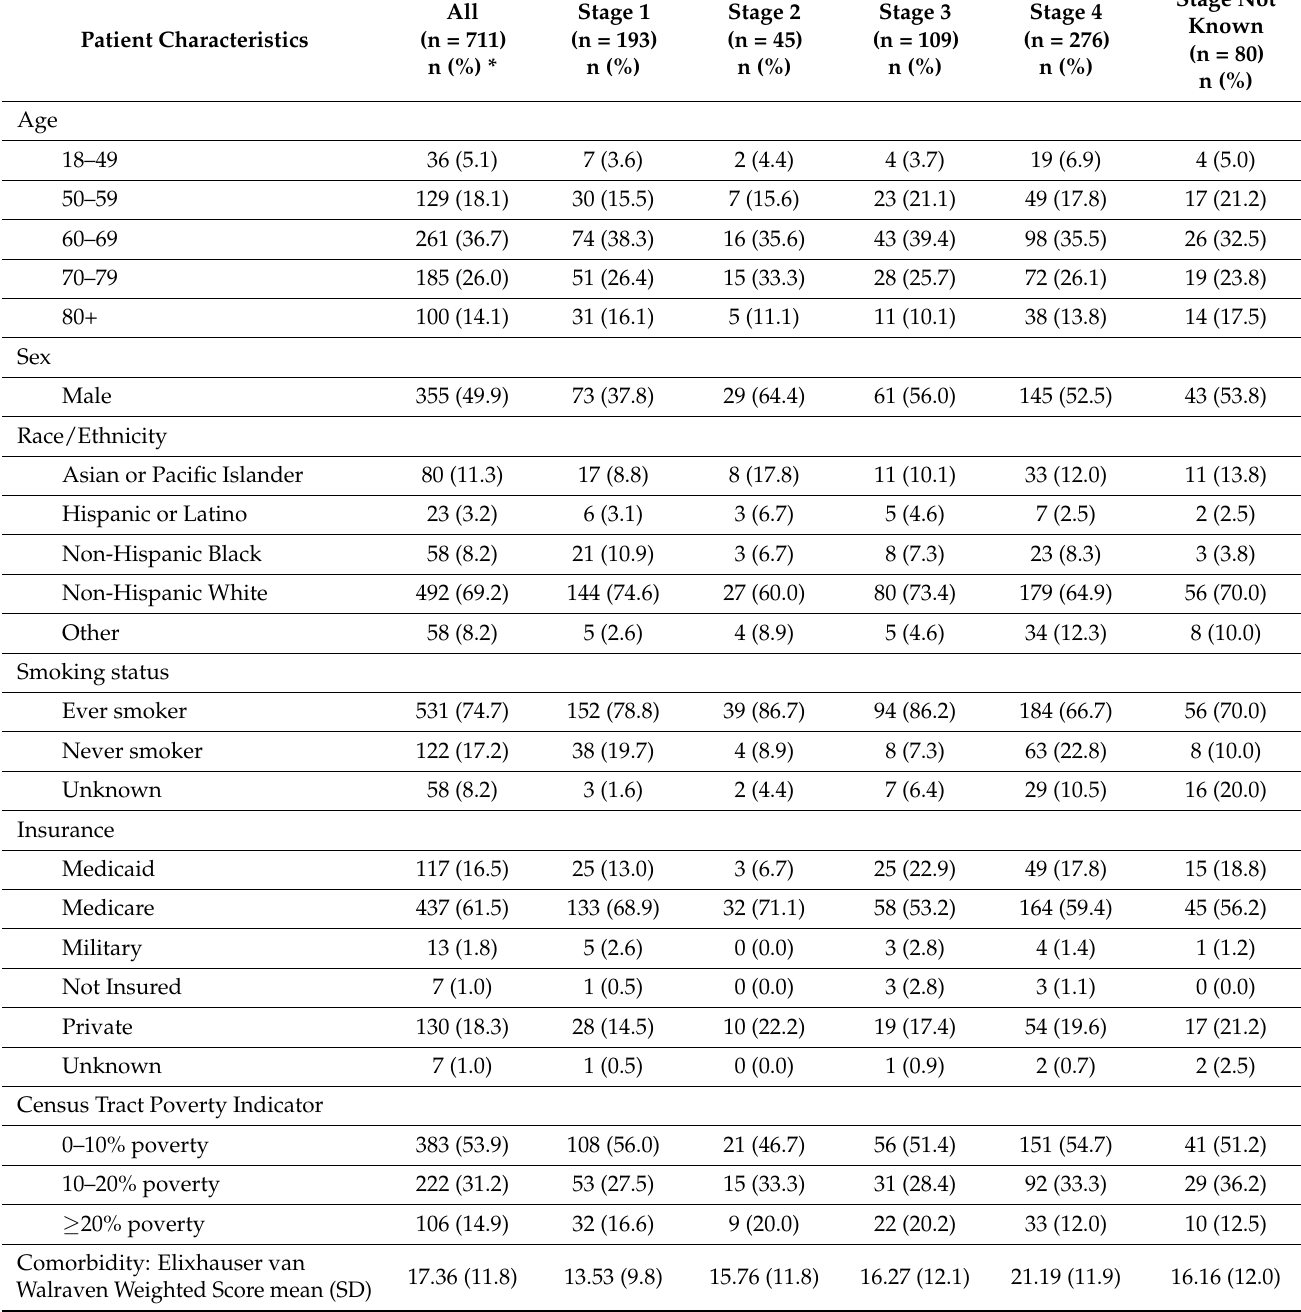
Table 1. Characteristics of patients with lung cancer by stage at